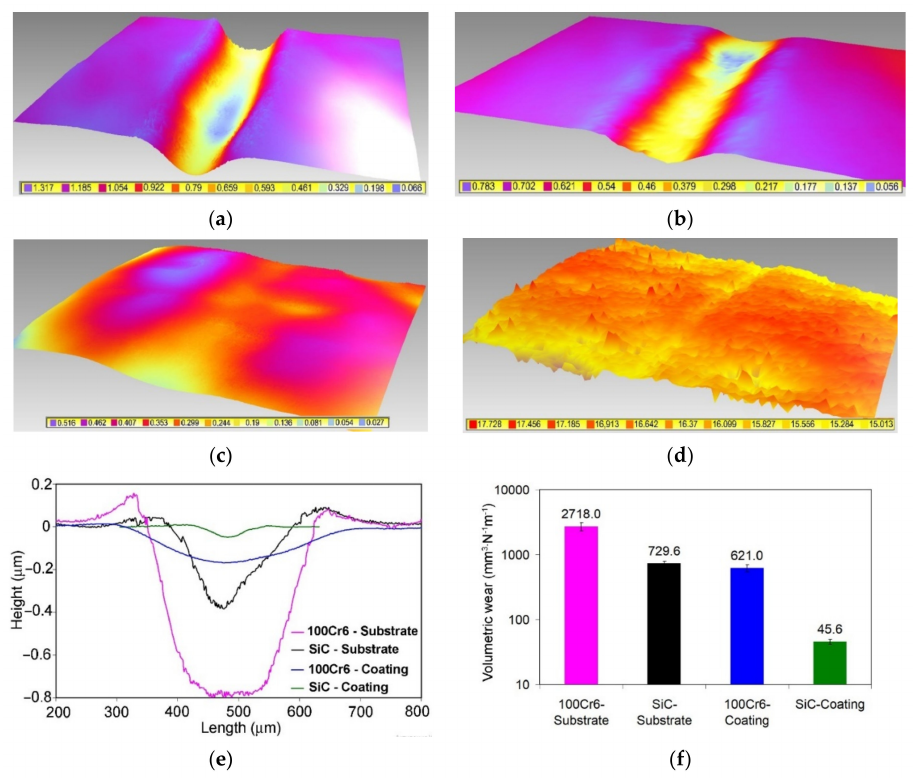
Figure 12. 3D images of the wear tracks for different sliding couples: ( a ) 100Cr6-substrate (steel of AISI 4145H grade), ( b ) SiC-substrate (steel of AISI 4145H grade), ( c ) 100Cr6-coating, ( d ) SiC-coating. Dry-sliding wear characteristics of the specimens: ( e ) wear track profiles, and ( f ) volumetric wear (The values of a profile height in Figure ( a – d ) are given in µ m).